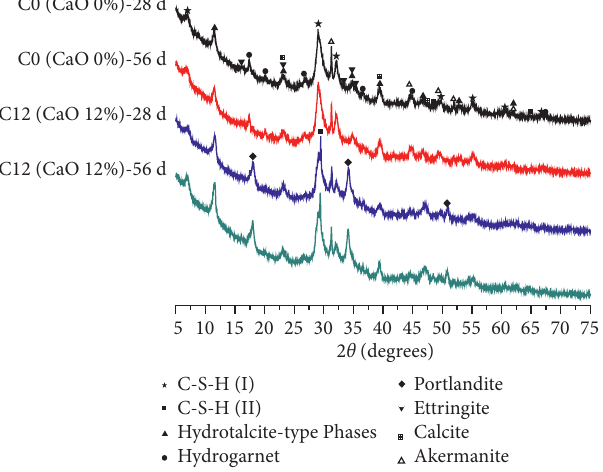
Figure 5: XRD patterns of C0 and C12 at 28 d and 56d. Table 7: Mean basal distances ( d (002) ) of C-S-H(I) in C0 and C12 at 28d and